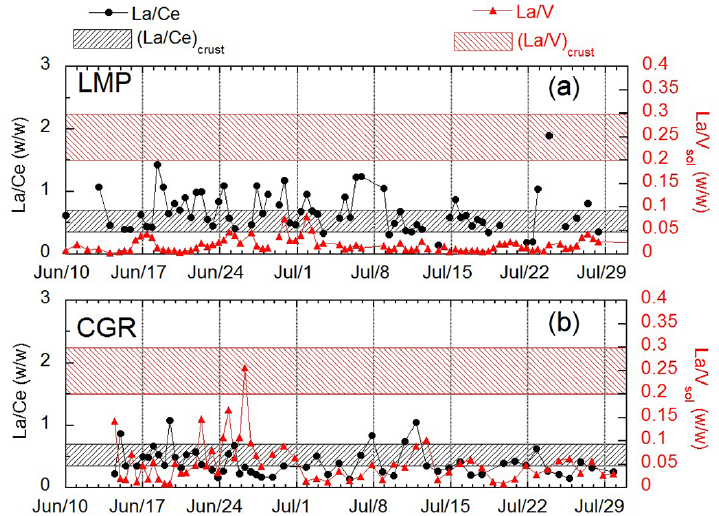
Figure 4. Time series of LCR and LVR at (a) LMP, and (b) CGR. The horizontal red and grey shadow areas in each plot represent the ranges of values for upper continental crust LVR and LCR,